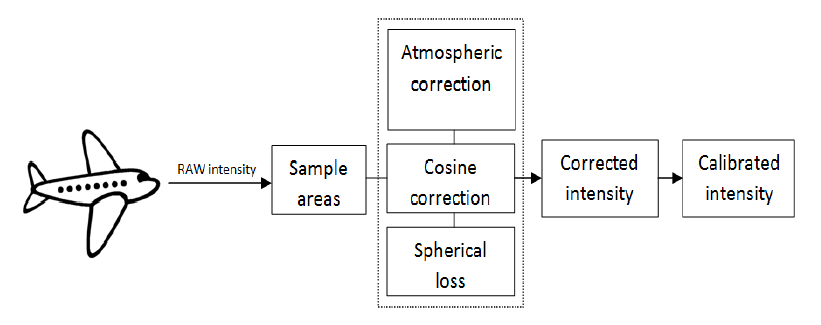
Figure 5. General workflow of calibrating the airborne laser scanner intensity